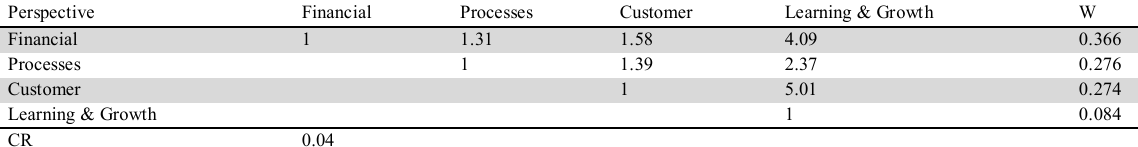
Weights and consistency ratio at the BSC